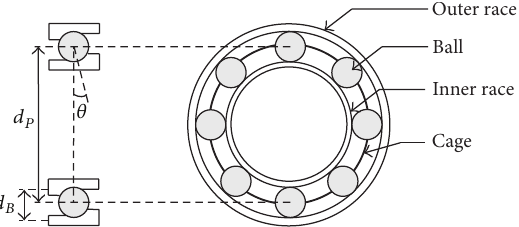
for the safe structure. Then, an X-bar control chart [24] can be considered which consists in a centerline (CL) with upper and lower control limits (UCL and LCL) as